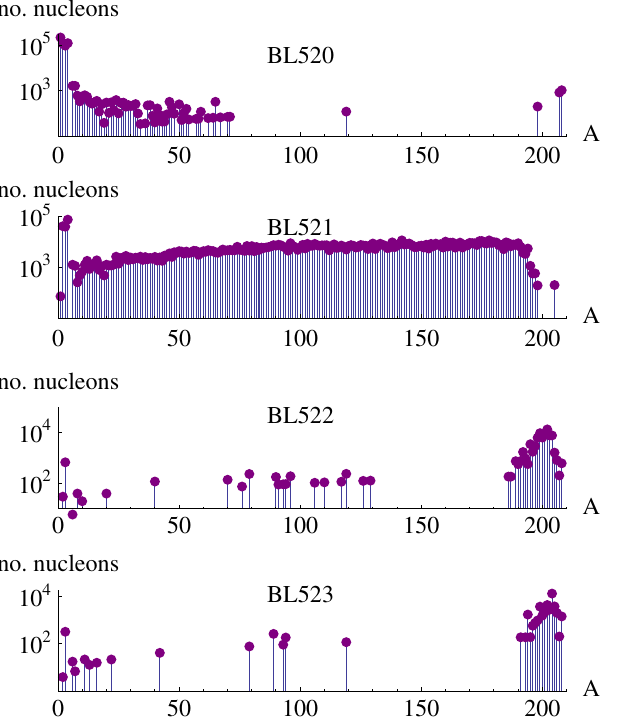
FIG. 15. (Color) The A distribution of ion fragments lost within 15 m upstream of each BLM at 106 : 4 GeV = nucleon and parallel collimator jaws as simulated with the FLUKA full method. The heights of the bars show the number of nucleons from ions having a certain A .